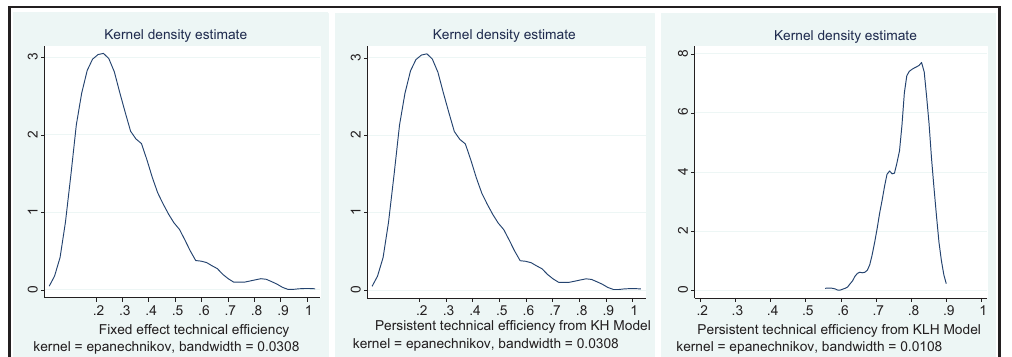
Figure 1 Distribution of persistent TE across different models, FE (left), KH (center), and KLH